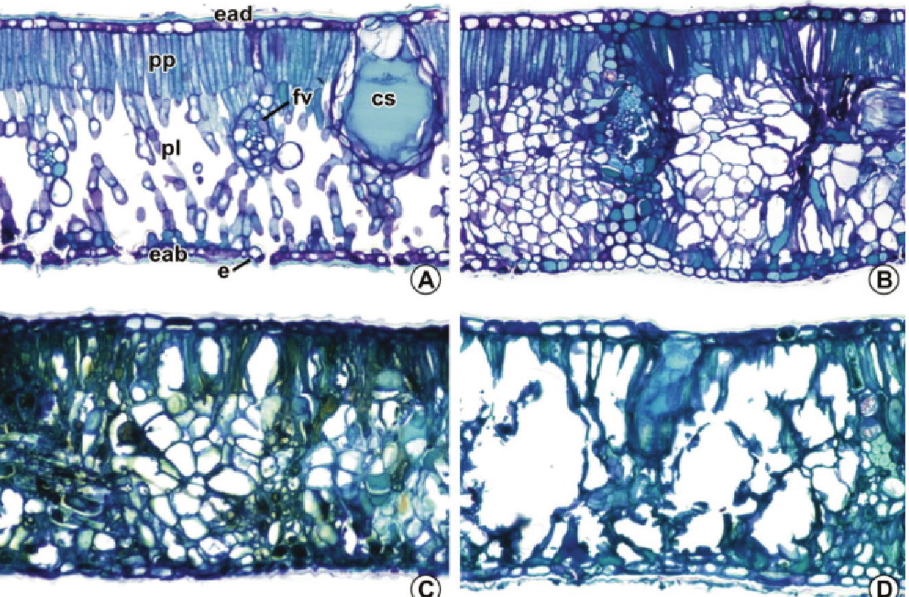
Figure 4. Cross-sections of the leaf blade of healthy clone 386 (a) and with lesions from ESBVRD (b-d). (a) overall appearance of the healthy interveinal region; (b) hyperplasia and hypertrophy of the mesophyll; (c) phenolization of the mesophyll; and (d) generalized cellular